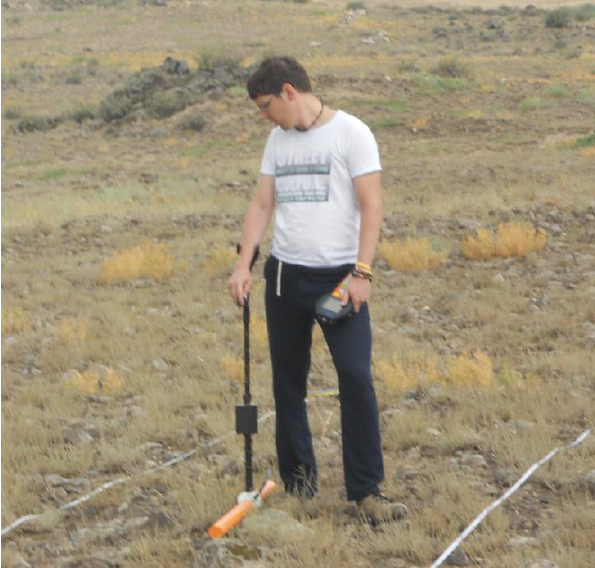
Figure 11. Armenia, Armavir province. CMD-MiniExplorer.